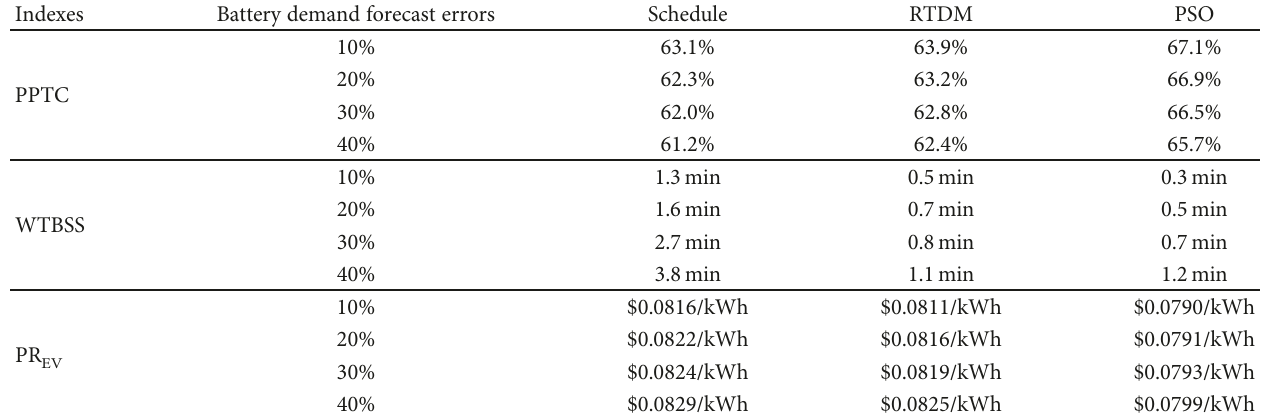
Table 2: Evaluation results for the di ff erent